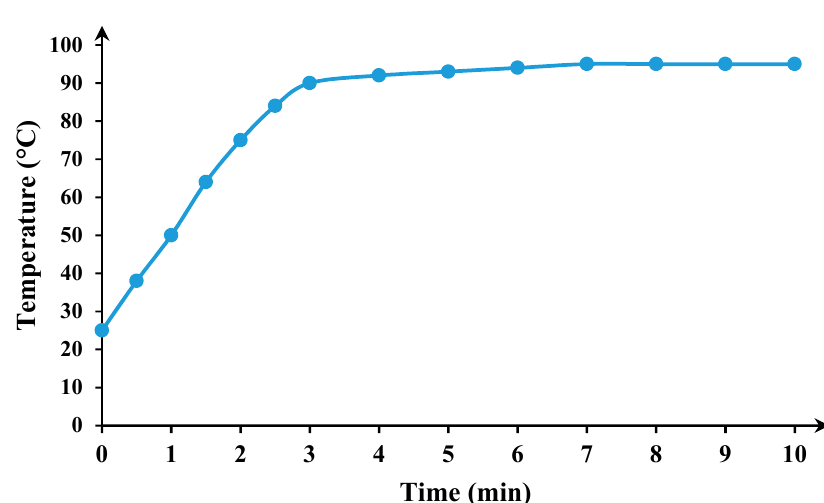
Figure 9. Leaching agent temperature fluctuation during microwave irradiation with 1000 W power.